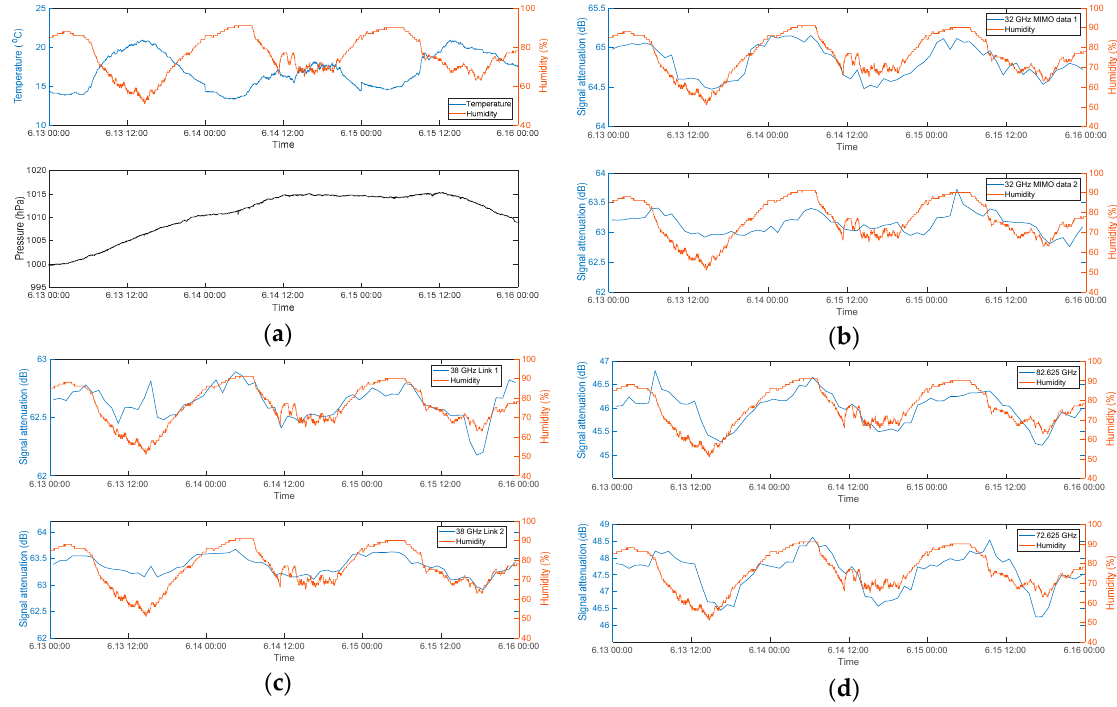
Figure 6. ( a ) The variations in temperature, humidity, and pressure during 13-15 June, 2017. ( b ) The variations in the signal attenuation and humidity of the 32 GHz link (link 1, data streams 1 and 2). ( c ) Links 1 and 2 at 38 GHz; ( d ) The 72.625 and 82.625 GHz links.